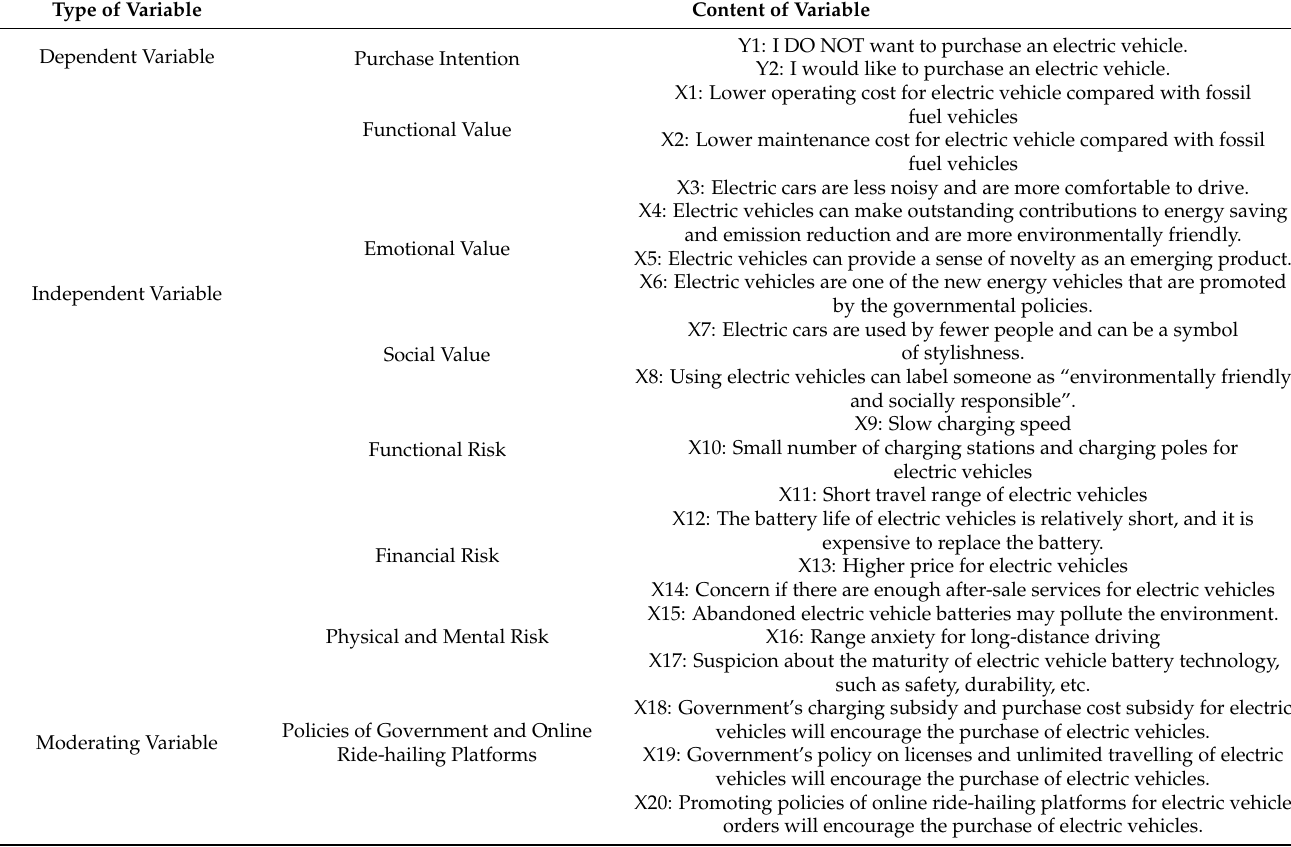
Table 2. List of model variables and survey questions.